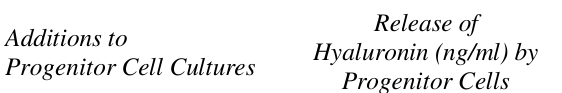
Table 4: Chemotaxis of Neutrophils to Aroclor or Conditioned Medium from PC Treated with Aroclor. In a two-chambered chemotaxis system, CMPC-Aroclor (6, 12, was placed in the lower chamber and 25, or 50 µM) neutrophils (1 X 10 6 cells) were placed in the upper chamber. After a 1hr incubation period, chemotaxis was determined by the nuMber of neutrophils that had migrated through the membrane pores to the lower